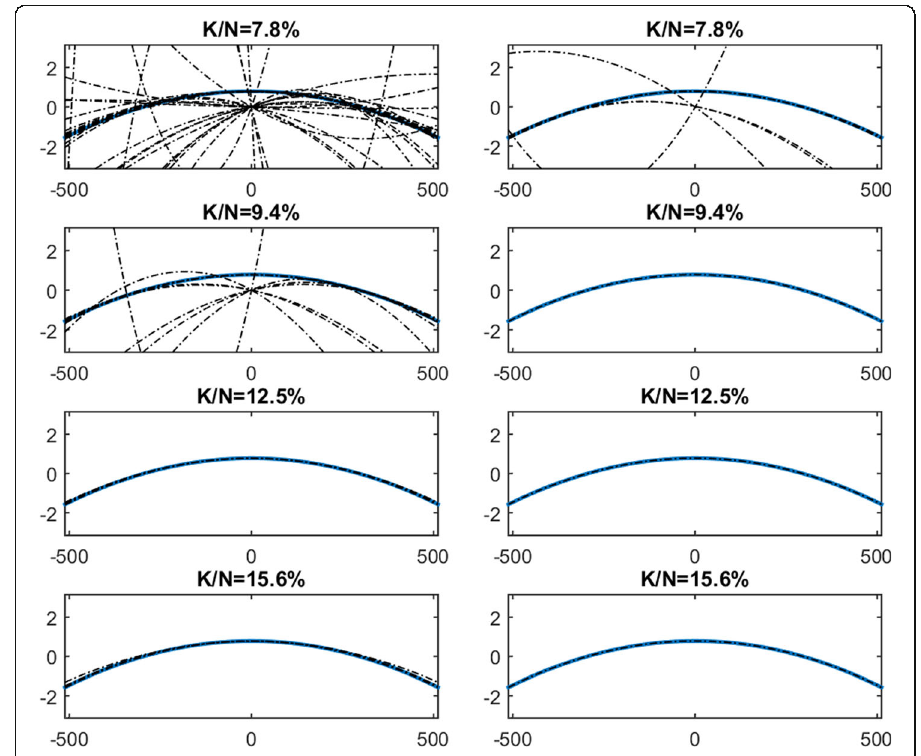
Fig. 3 Cubic phase signal — 100 trials of the RANSAC procedure without (left column) and with refinement (right column) for cubic various K / N : first row — 7.8%; second row — 9.4%; third row — 12.5%; fourth row — 15.6%. Blue line exact IF value; black lines —